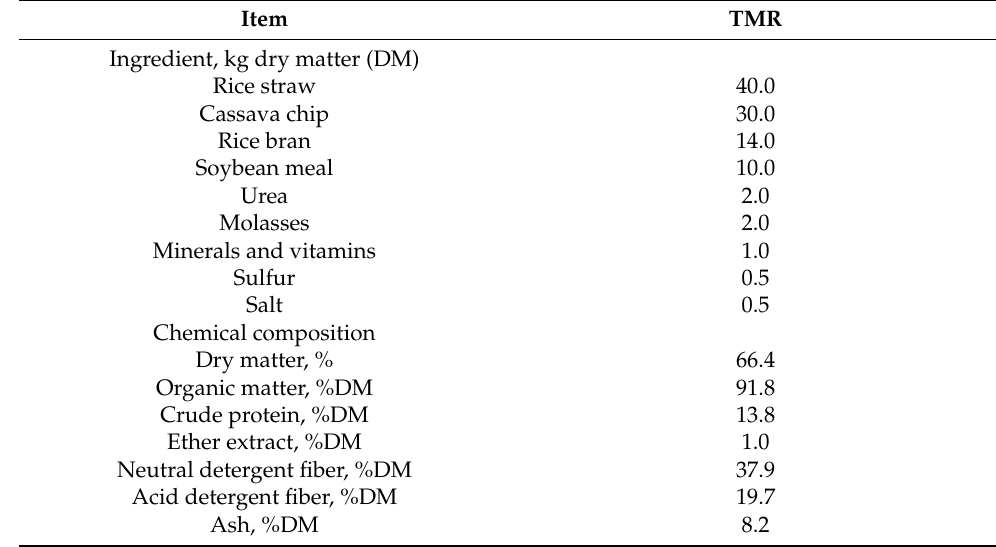
Table 1. Ingredients and chemical composition of the diet used in the experiment. Item TMR Ingredient, kg dry matter (DM) Rice